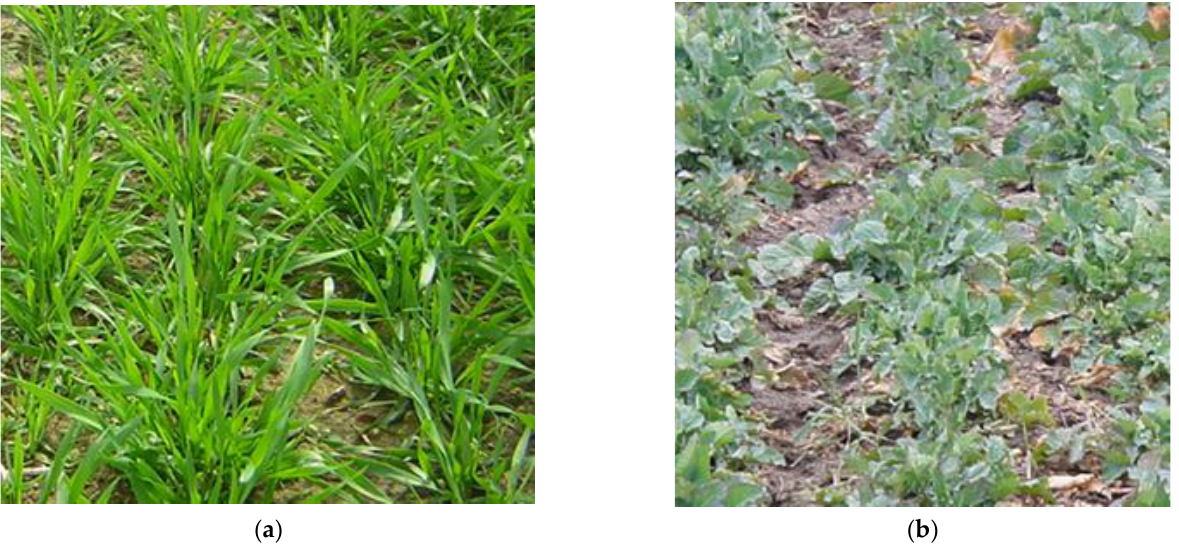
Figure 6. The Cardinal Stage 1 (CK1): winter wheat (monocot) ( a ) and winter oilseed rape (dicot) ( b ). Photos by W. Grzebisz.